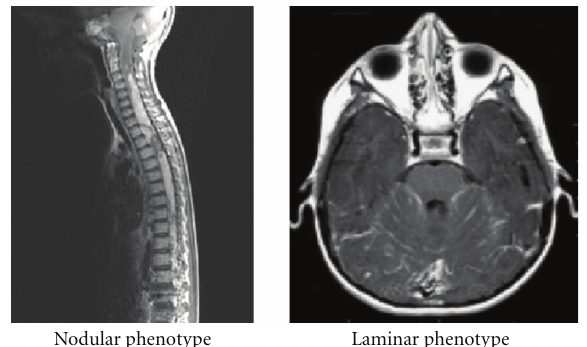
Figure 1: Metastasis